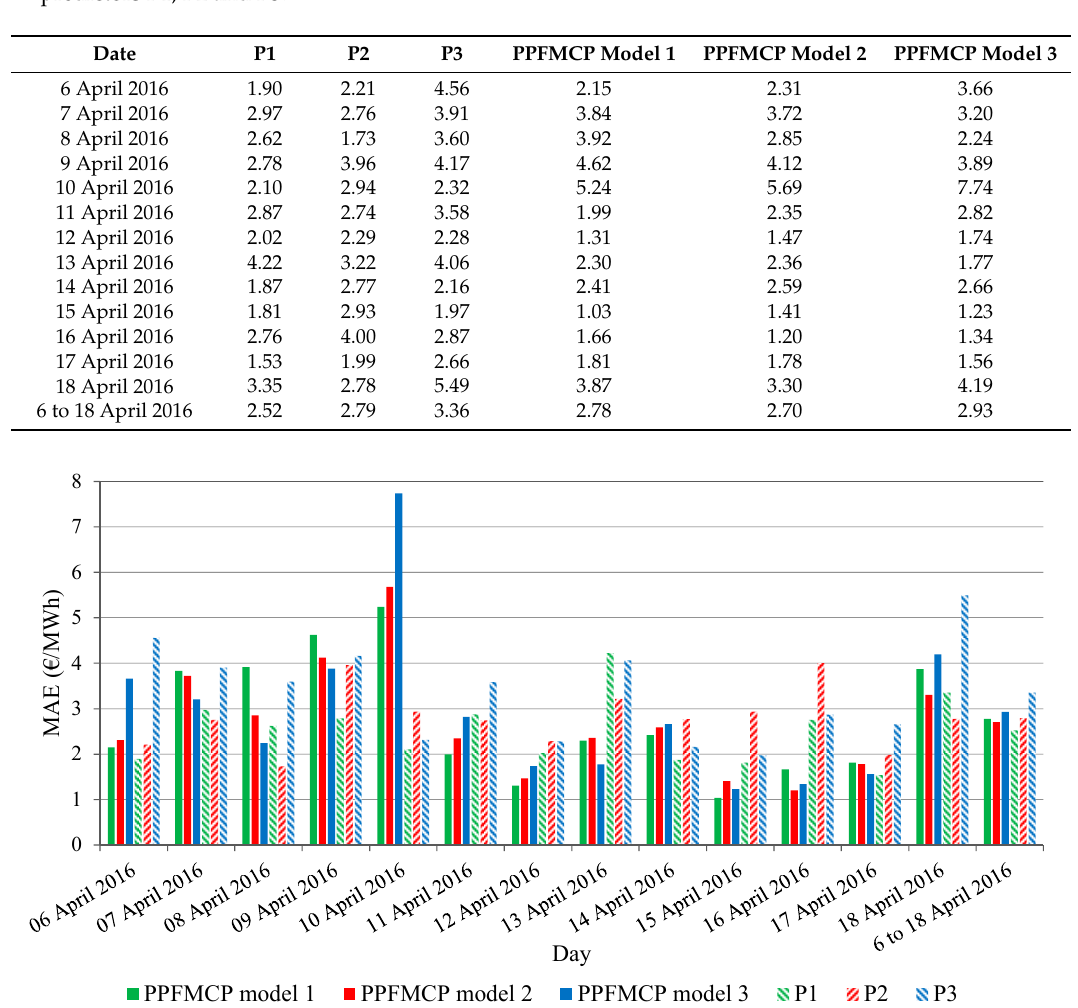
Table 6. Mean absolute error values of point forecasts of PPFMCP models and of the three best predictors P1, P2 and P3.